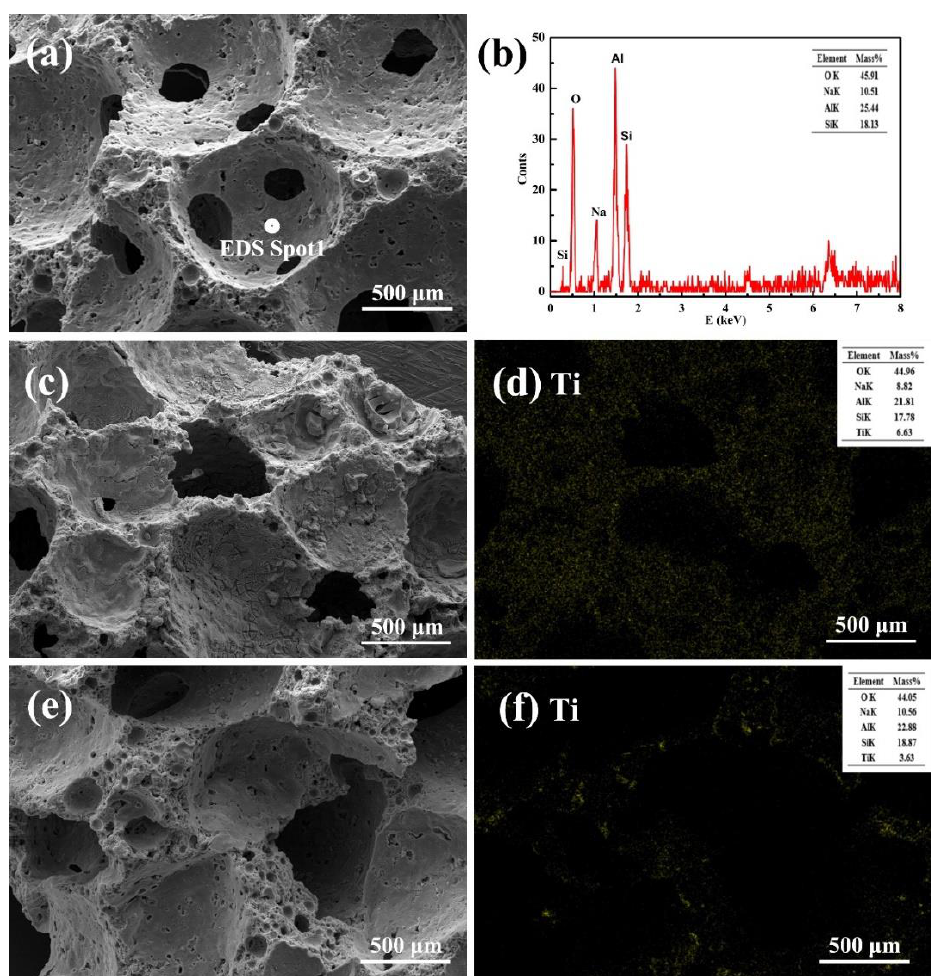
Figure 2. SEM images of geopolymer and geopolymer-TiO 2 composite synthesized via two methods: